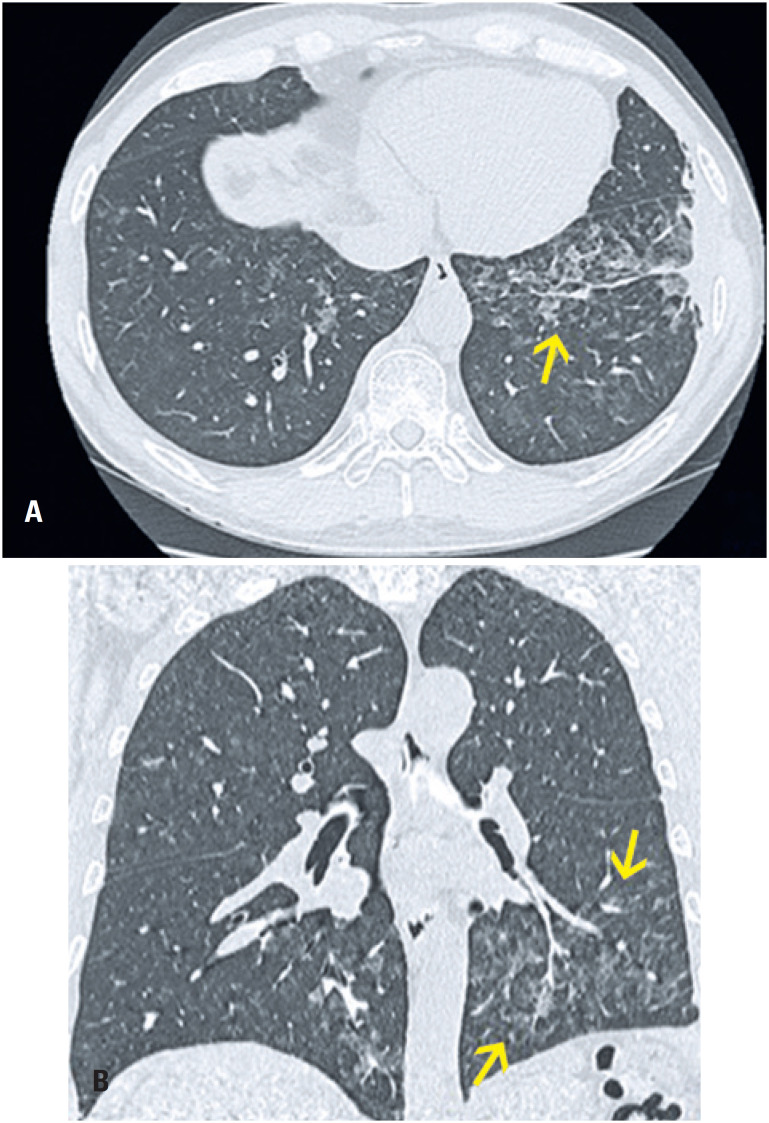
Homem, 50 anos, assintomático, realiza o exame para
check-up
. Tomografia computadorizada (A) Em plano de corte axial (B) Reformatação coronal: múltiplas opacidades alveolares em vidro fosco em ambos os pulmões, predominantemente centrolobulares nos campos inferiores. Os achados se mantiveram no exame de controle em 3 meses, tendo sido realizada a biópsia, e o diagnóstico definitivo foi de pneumonia lipoídica